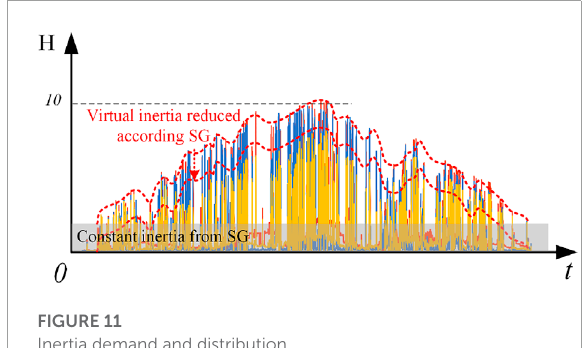
FIGURE 11 Inertia demand and distribution.